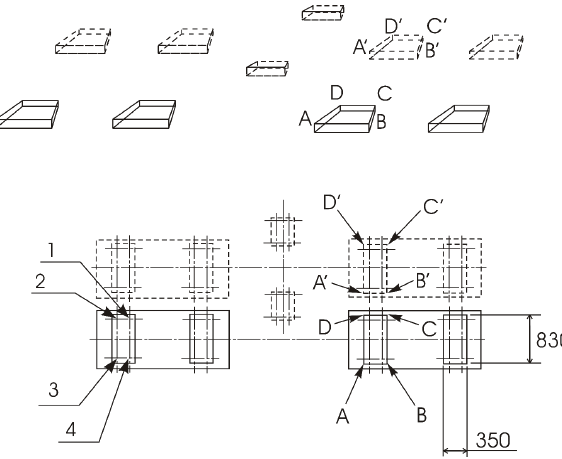
Figure 32: Possible positions of the rectangular plates where the brackets of a linear electromagnetic actuator could be fixed.